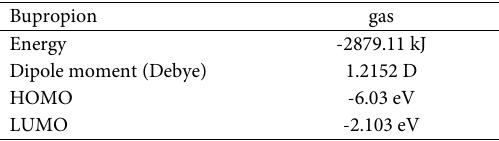
Table 1. Energy data and dipole momentum of Bupropion by B3LYP/6-311+G(d, p)